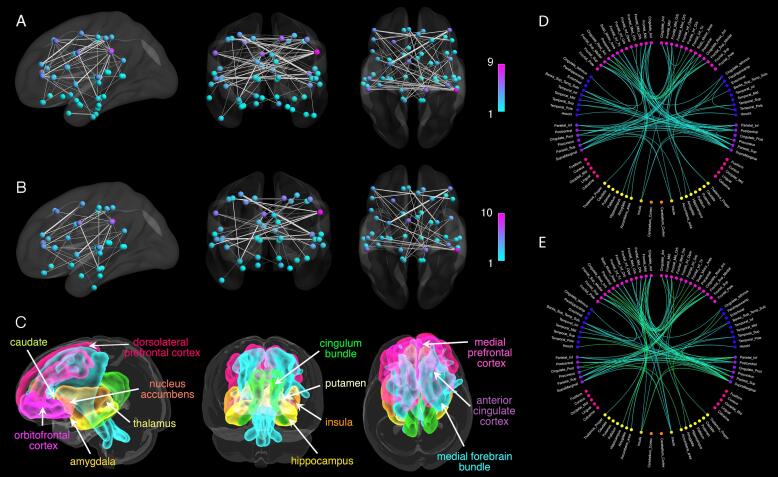
A) Network of significantly reduced fractional anisotropy (FA)-weighted connectivity in the group of stroke patients with depression compared to the healthy control group. B) Network of significantly increased free-water (FW)-weighted connectivity in the group of stroke patients with depression compared to the healthy control group. T-statistics are set to a supra-threshold of 3, which corresponds to p = 0.001. Subnetworks are significant at pFWE < 0.05. Node colour reflects number of connections in subnetwork (degree of a node in the subnetwork), ranging from blue (few connections) to pink (many connections). Edge weights reflect t-statistic magnitude, whereby thicker edges correspond to higher t-statistics. C) Grey matter (warm colors) and white matter (cold colors) structures constituting the reward system. The medial forebrain bundle (cyan) and the cingulum bundle (green) interconnect the grey matter structures of the reward system. Connectograms of the significant D) FA and E) FW networks. Node color correspond to different lobes and subcortical regions: pink = frontal lobe, blue = temporal lobe, purple = parietal lobe, magenta = occipital lobe, yellow = subcortical structures, light orange = insular cortex, orange = cerebellum. Connection color represents F-statistics magnitude, ranging from cyan (low F-statistic value) to green (high F-statistic value). (For interpretation of the references to color in this figure legend, the reader is referred to the web version of this article.)